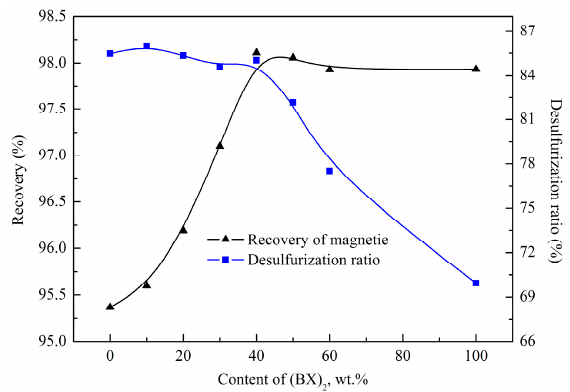
Figure 5. The magnetite recovery and desulfurization ratio in flotation concentrate with mixed collector at different combinations (mixed collector 125 g/t, NaSiF 6 500 g/t, pine oil 46 g/t, pH = 6).